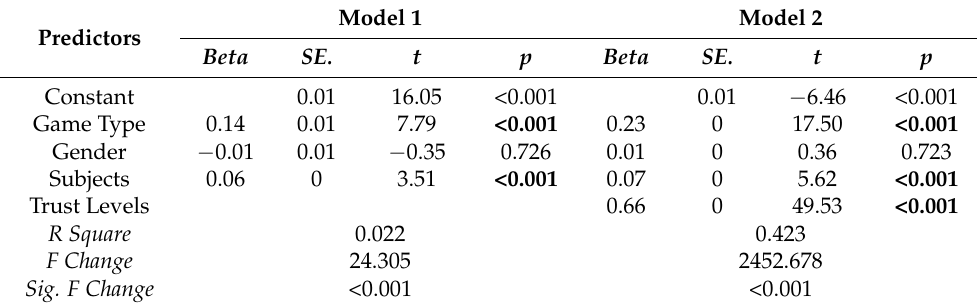
Table 3. Hierarchical linear regression analysis on percentage